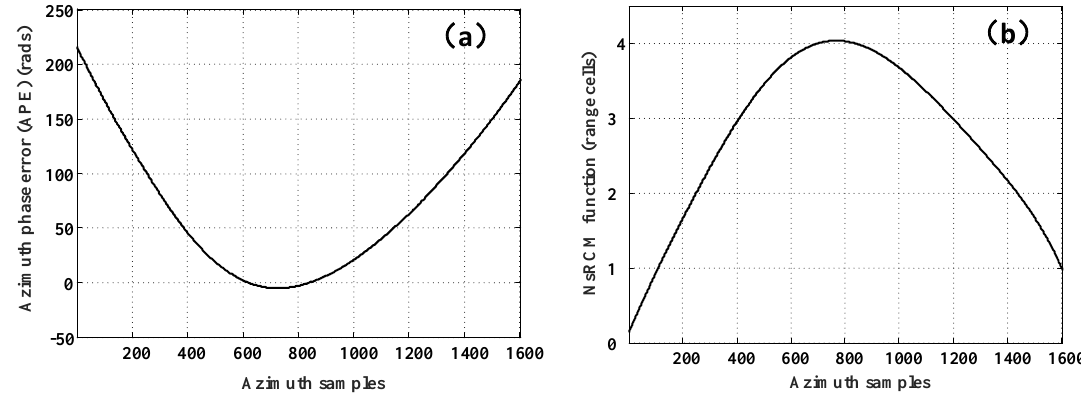
Figure 15. ( a ) Estimated APE function and ( b ) calculated NsRCM error